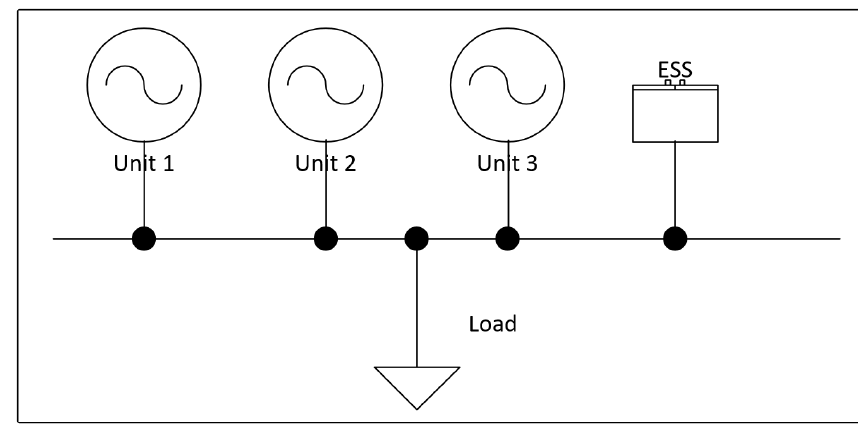
Figure 7. Parallel components in a microgrid.